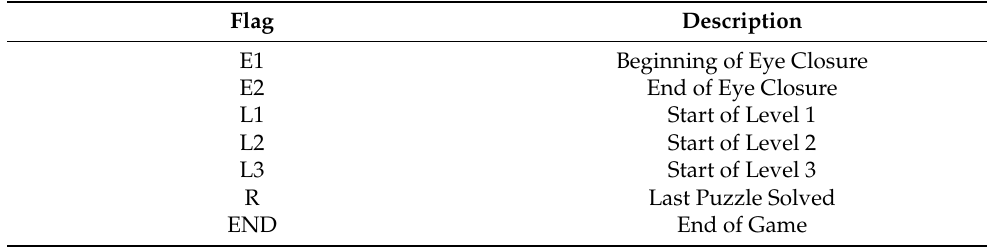
Table 1. List of flags in EEG